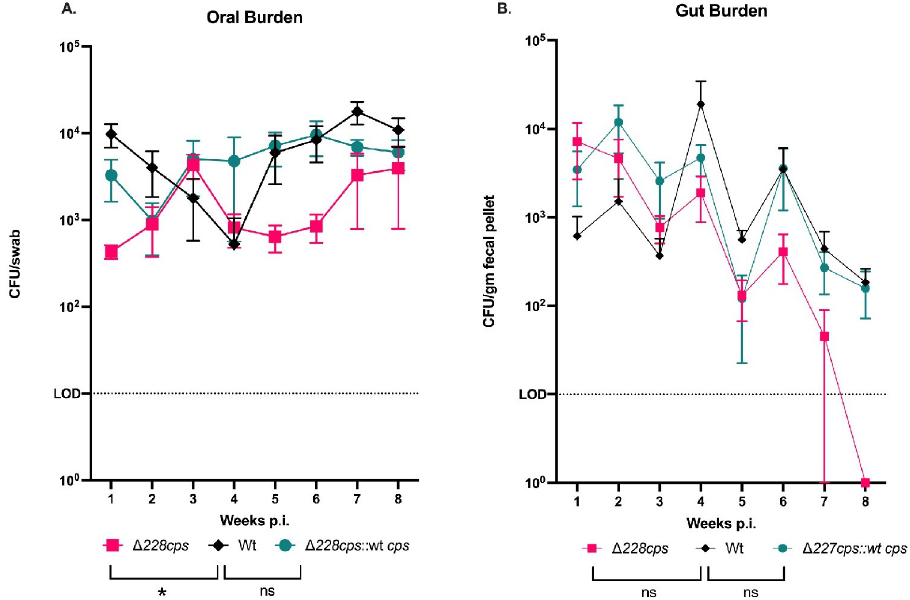
Fig 7. Loss of capsule significantly reduces N . musculi bacterial burden in the mouse oral cavity but not the gut during persistent colonization. A/J mice were orally inoculated with either Wt, Δ 228cps or complemented strains (n = 5 per group). Oral swabs and fecal pellets were plated on selective agar at weekly intervals post inoculation to recover viable N . musculi . Total oral bacterial burden is significantly decreased in animals inoculated with the Δ 228cps mutant in comparison to Wt controls (Kruskal Wallis test with Dunn’s comparison, � p = 0.0178, comparisons denoted by brackets in the legend), while no significant difference is observed in samples isolated from the gut. Bacterial burden is normalized to CFU/ml total sample volume for oral samples, and CFU/gm fecal pellet for gut samples. Points indicate mean burden by group with bars representing